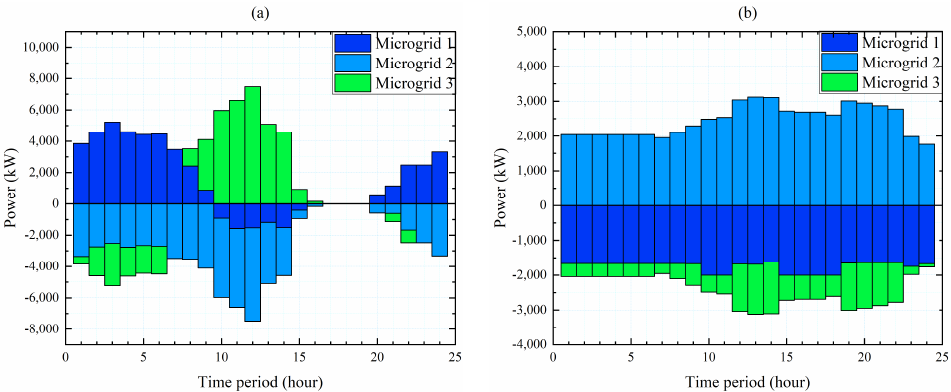
15 of 20 Figure 6. Convergence result of the coalition total running cost for upper-layer hot-sharing sub−problem P2. (a) Iterative result of the micro−grid ① . (b) Iterative result of the micro−grid ② . (c) Iterative result of the micro−grid ③ . (d) Iterated results of the alliance costs. At the same time, the lower-level electronic sharing sub-problem P1 optimizes the total operating cost of the alliance from 193,320 CNY at the negotiation breaking point to 155,641 CNY; the upper-level heat-sharing sub-problem P2 can continue to iteratively op- timize the total alliance operating cost to 122,395 CNY. The effectiveness of the distributed optimization algorithm based on the Nash game is proposed effectively in this paper.